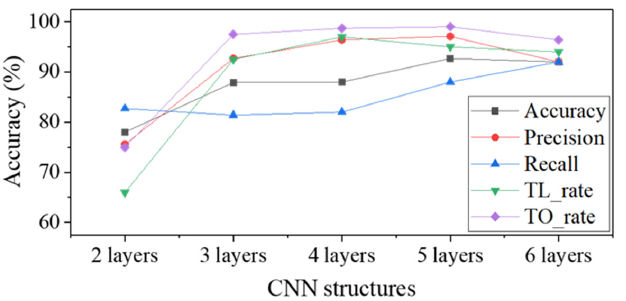
Figure 6. Graph depicting the defect inspection results according to the number of layers. Figure 7 shows the CAM images according to the depth of the CNN model. For